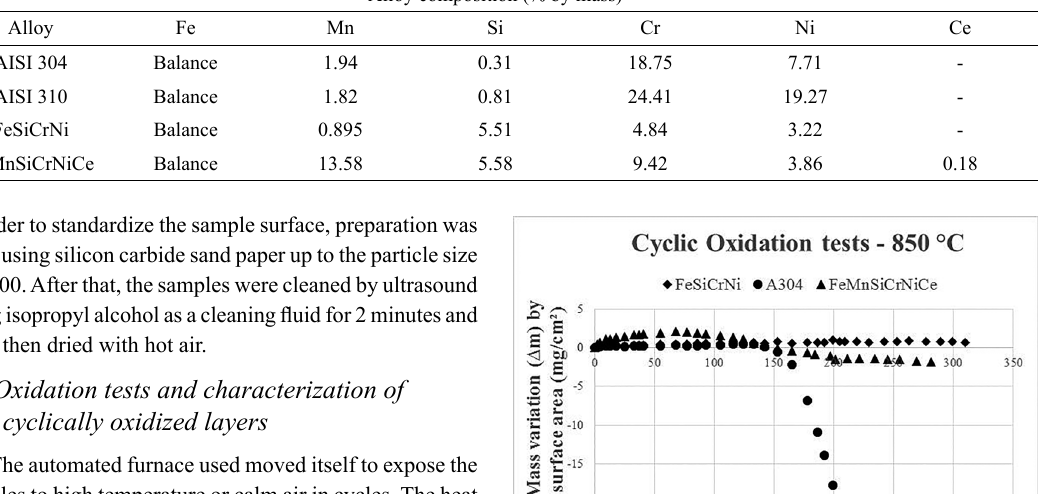
Table 1. Chemical composition in wt % of the alloys (determined by EDS). Alloy composition (% by mass)